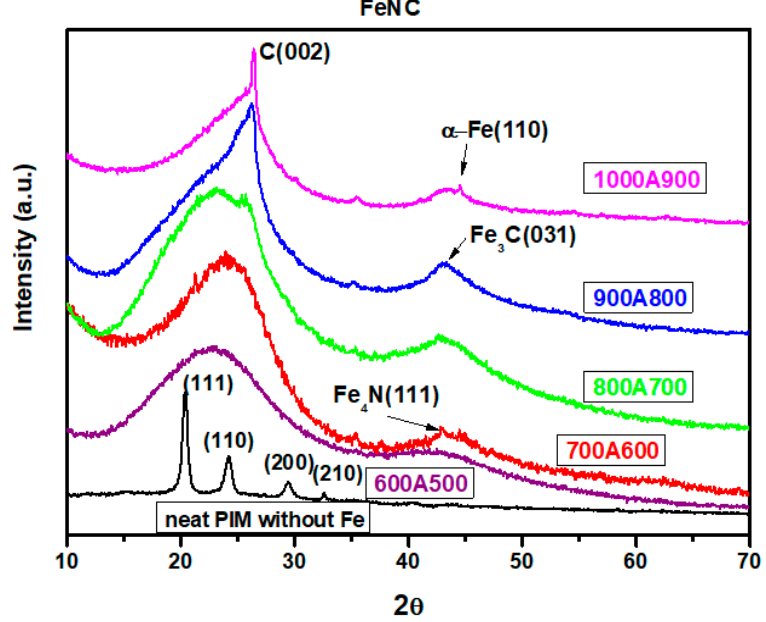
Figure 4. X-ray diffraction patterns of neat PIM and FeNCs prepared with different calcination Figure methods.